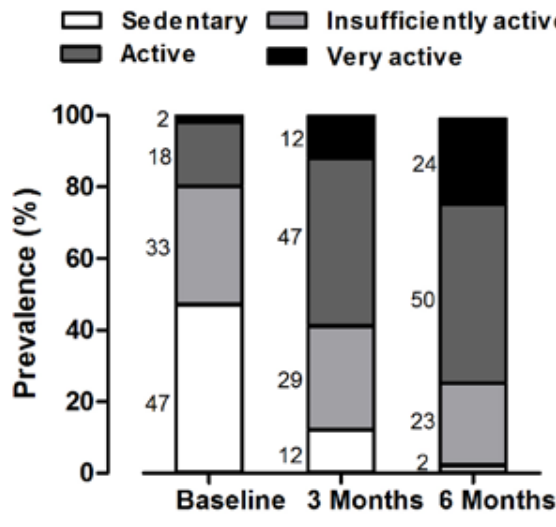
Figure 2. Physical activity